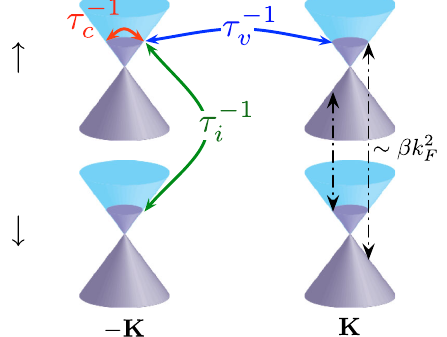
FIG. 4. Charge, valley, and isospin relaxation and mixing in topological semimetals. We depict the different relaxation proc- esses in disordered topological semimetals. Charge is relaxed by processes that scatter within a single Weyl node ( τ − 1 ); valley c pseudospin (indicated by node position (cid:2) K Þ is relaxed by processes involving large momentum transfer, which for screened impurities leads to strong suppression relative to charge relax- ∼ τ − 1 ð k = 2 K Þ 4 ; and in the Dirac case, the point-group ation τ − 1 v c F isospin (indicated by ↑ and ↓ ) is relaxed by scattering between the two Weyl nodes at a single Dirac point, which are shown separately for clarity but are, in fact, degenerate. Finally, curvature terms in the Dirac case mix electronlike (holelike) isospin- ↑ states with holelike (electronlike) isospin- ↓ states with a strength of approximately β k 2 . Note that, in fact, the isospin F relaxation occurs by a combination of this mixing and